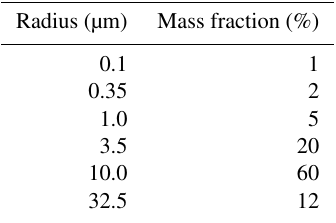
Table 1. Size distribution of the ash particles in the FLEXPART